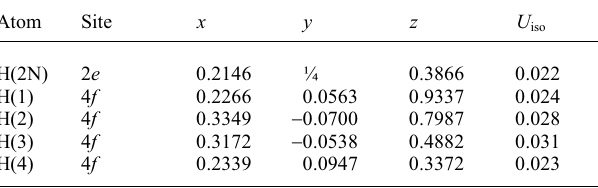
Table 2. Atomic coordinates and displacement parameters (in Å 2 )